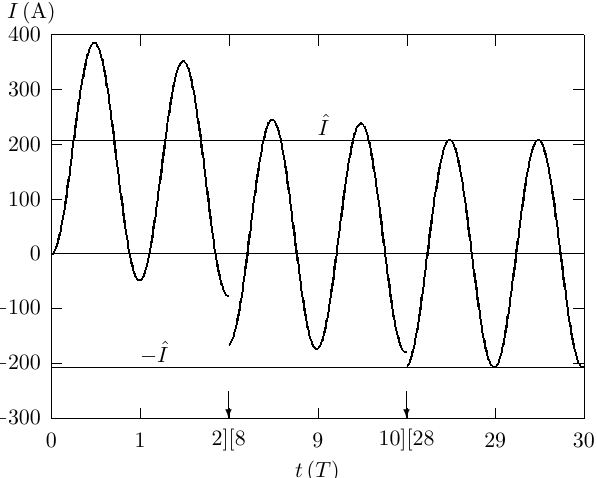
Figure 3. Example 1, α = 0, f = 1 kHz: The dependence of current on t in three time intervals: [ 0,2 T ] , [ 8 T ,10 T ] and [ 28 T ,30 T ] .